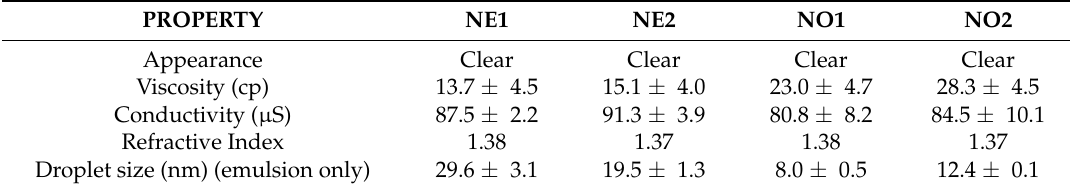
Table 2. Physical and chemical characterization of the various nanoemulsion formulations defined in Table